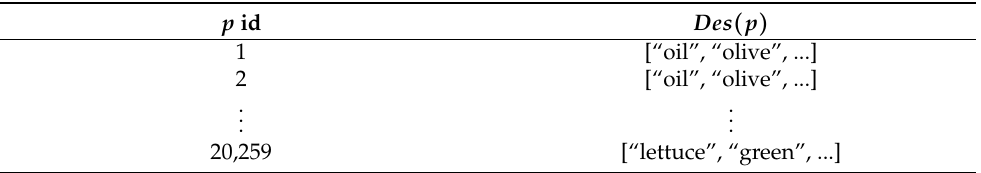
Table 12. Example of the list which contains the vectors of words belonging to each product consid- ering the Ingredientes column ( product_words